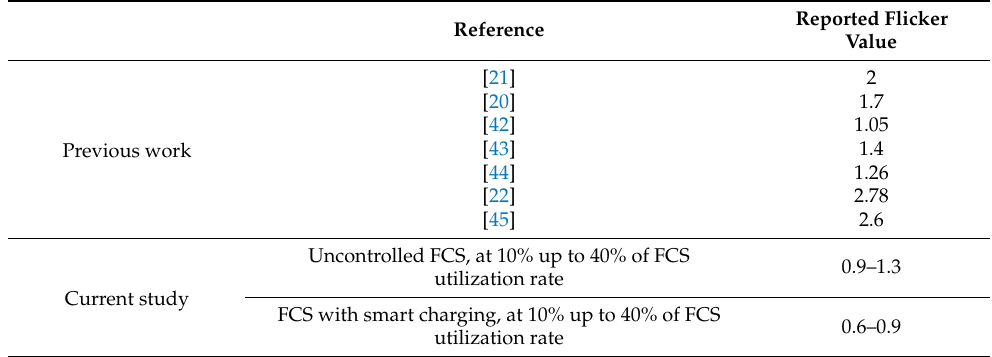
Table 4. Comparison of the previous work and the proposed method according to flicker